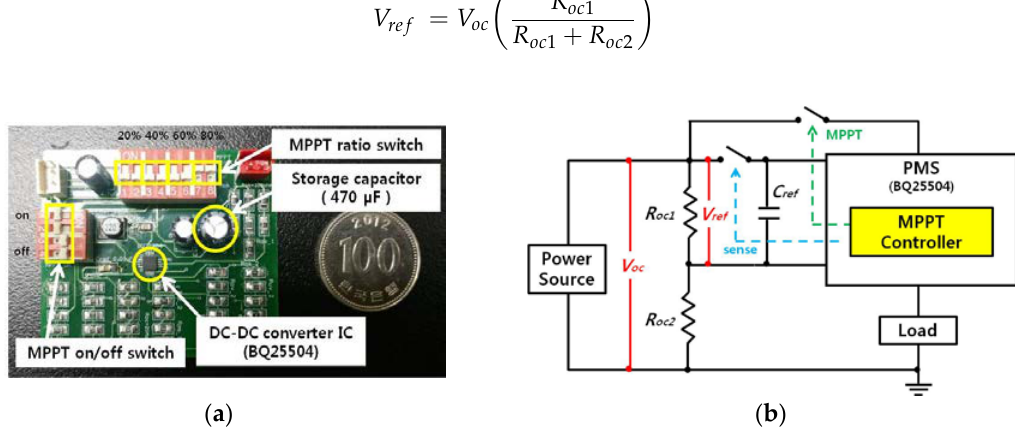
Figure 4. Power management system (PMS) operated under constant voltage ratio maximum power point tracking (MPPT): ( a ) Printed circuit board (PCB) implementation; ( b ) Schematic of the developed PMS with MPPT control.